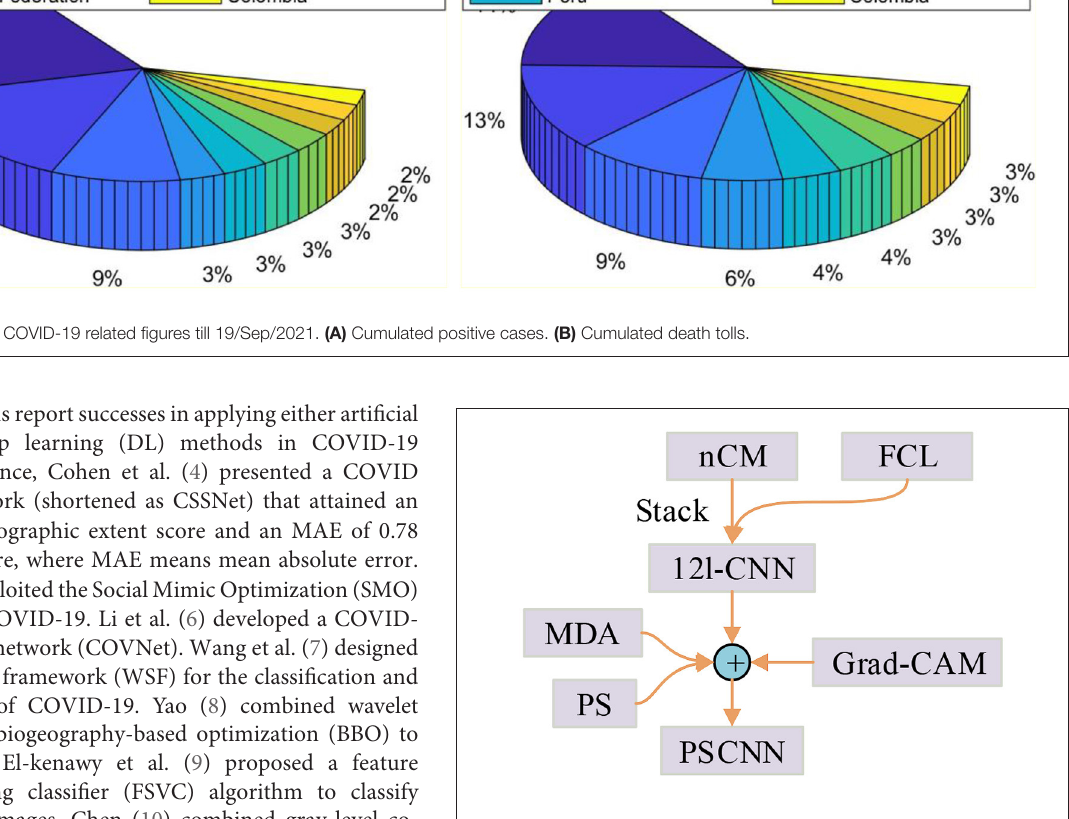
FIGURE 2 | Relationship of our